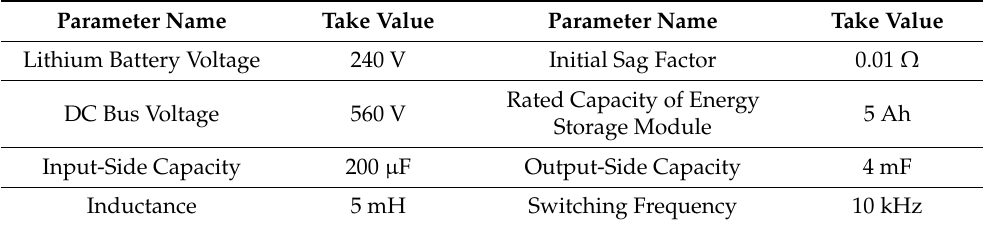
Figure 14. Simplified simulation model of the vessel system. Table 5. Table of simulation parameters for applying sag control.